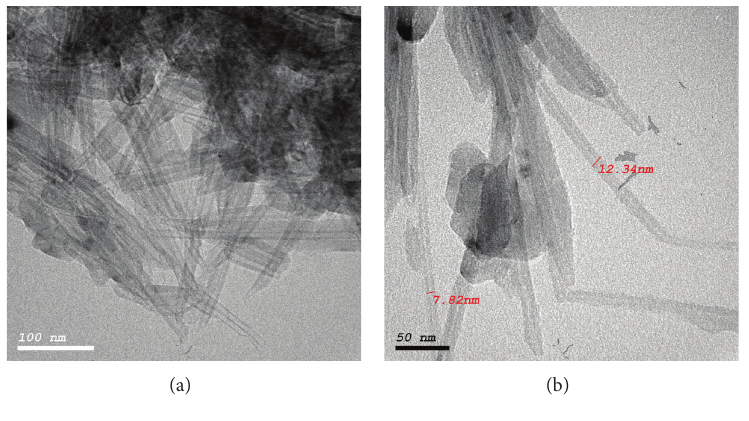
Figure 2: HRTEM images of CNTs.